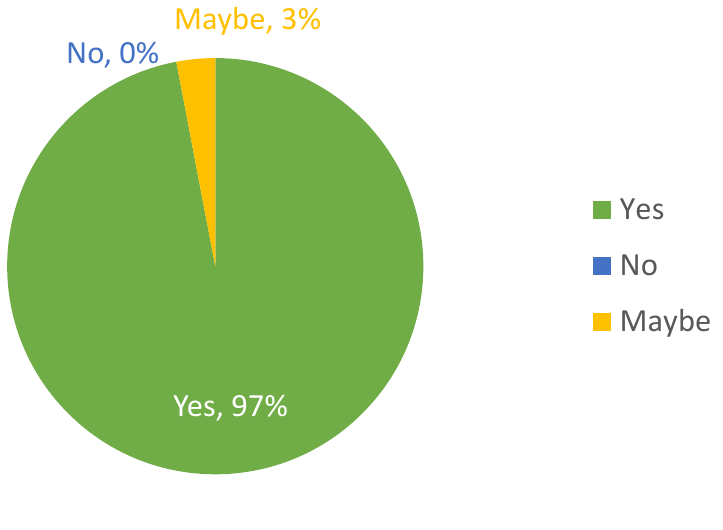
Figure 1. Percentage (%) of respondents on the role of e-banking as a marketing tool in marketing the services of